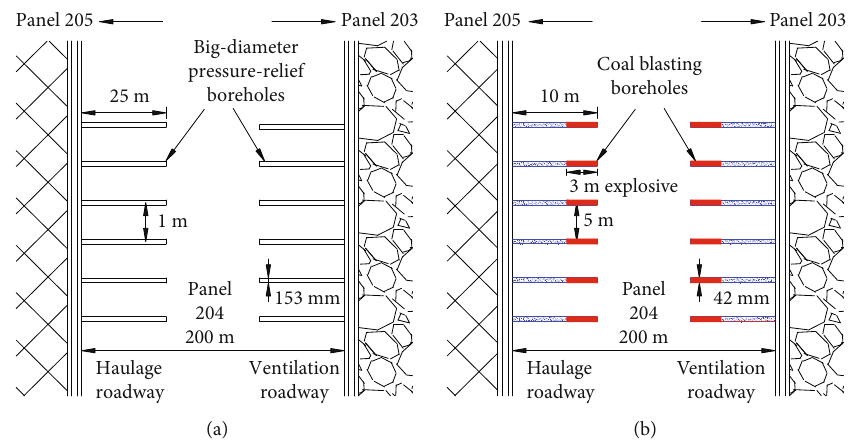
Figure 13: Schematic diagram of pressure-relief measures in the coal wall of panel 204: (a) big-diameter pressure-relief boreholes; (b) coal blasting